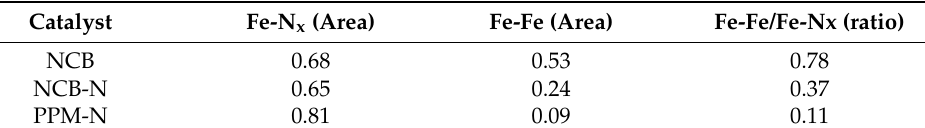
Table 3. Ratio of Fe-Fe/Fe-N x which is calculated from EXAFS fitting.